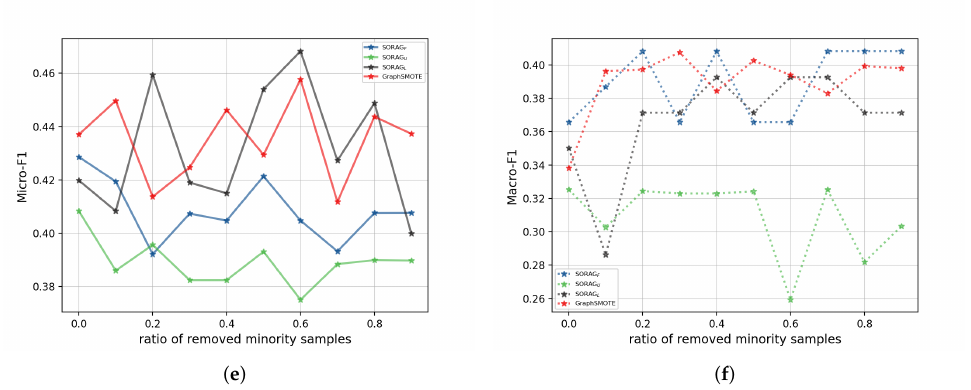
Figure 6. Influence of imbalance ratio: ( a ) B LOG C ATALOG 3, M ICRO -F1; ( b ) B LOG C ATALOG 3, M ACRO -F1; ( c ) F LICKR , M ICRO -F1; ( d ) F LICKR , M ACRO -F1; ( e ) Y OU T UBE , M ICRO -F1; ( f ) Y OU T UBE , M ACRO